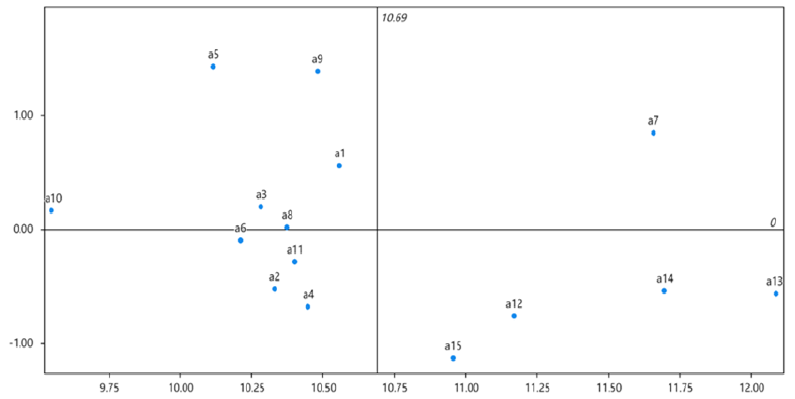
Figure 2. Cause – result degree diagram. Figure 2. Cause–result degree